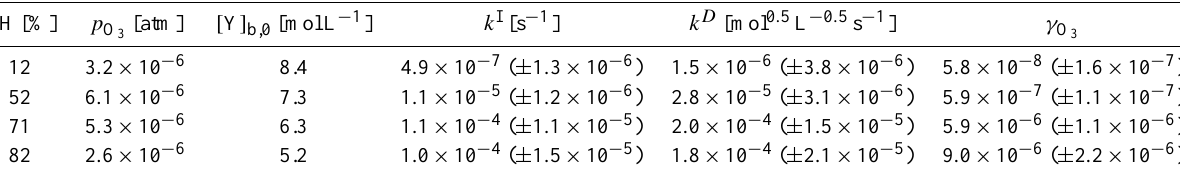
Table 1. First order rate constants for the reaction limited case ( k I ) and rate constants under reacto-diffusive limitation ( k D ) with standard error, determined from the linear fits and uptake coefficient for O 3 on shikimic acid calculated assuming reaction limitation.